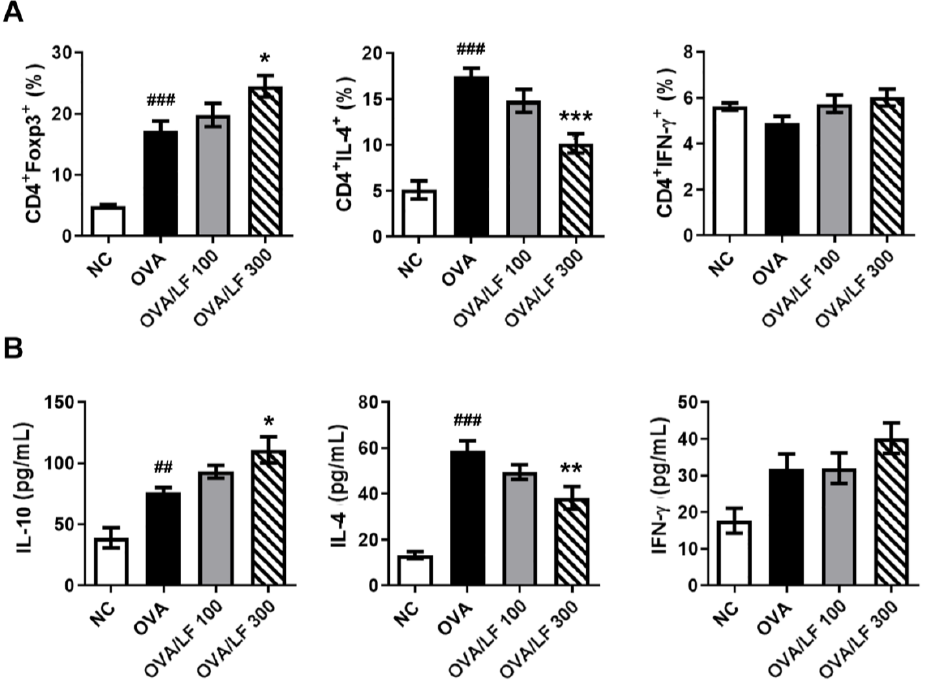
Figure 4. Lactoferrin increased the proportion of CD4 + Foxp3 + Tregs and decreased IL-4-producing T cells in the splenocyte population. ( A ) The levels of OVA-specific Foxp3, IL-4, and IFN- γ in splenocytes were determined by flow cytometry with specific antibodies. ( B ) The levels of IL-10, IL-4, and IFN- γ secreted by splenocytes were detected by ELISAs. The data are expressed as the mean ± S.E.M. values ( n = 5). ## p < 0.01, ### p < 0.001 vs. the NC group; * p < 0.05, ** p < 0.01, *** p < 0.001 vs.